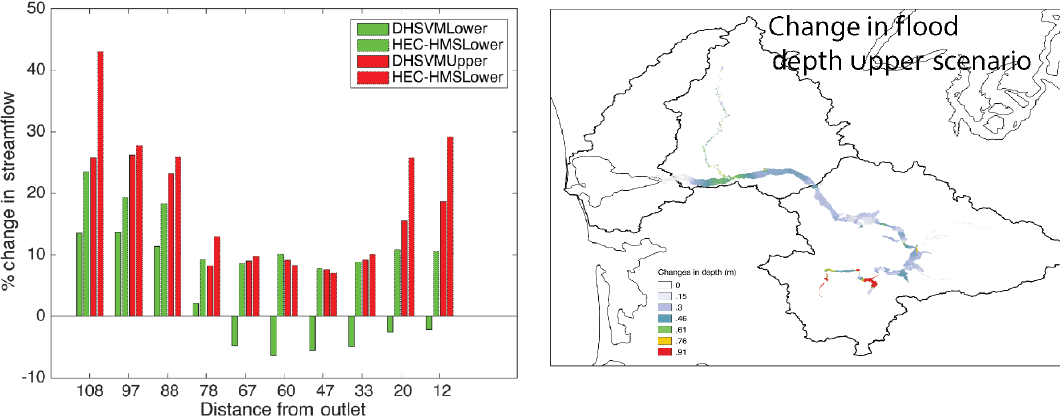
Figure 12. Change in streamflow and flood depth along main